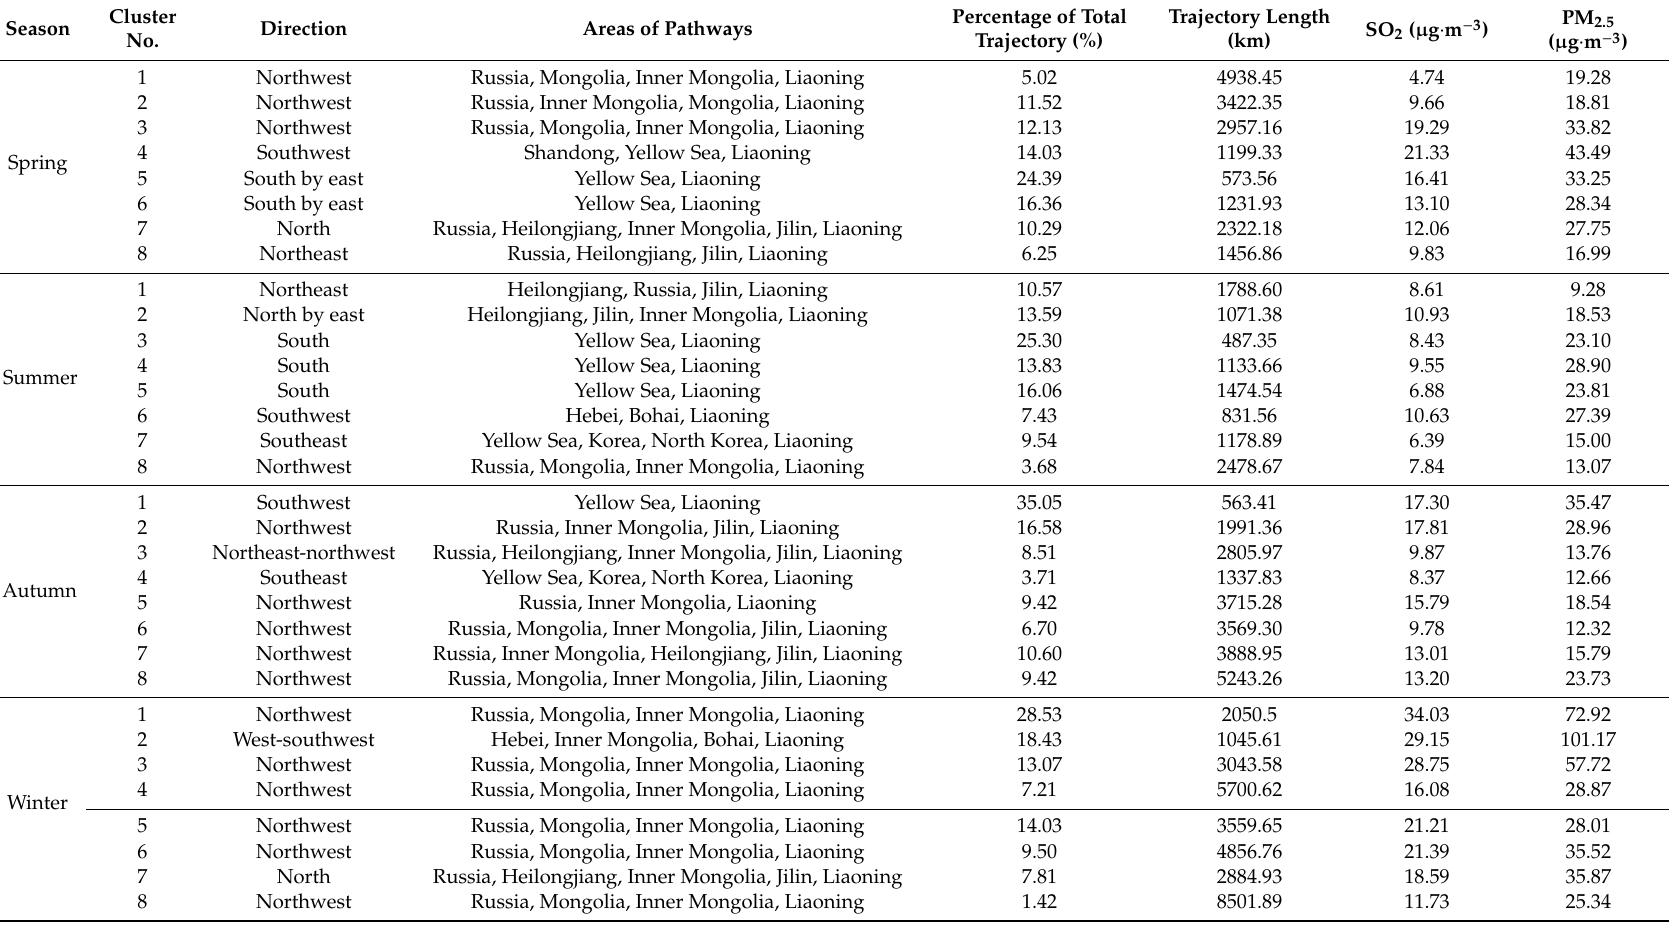
Table 1. Clustering results of backward